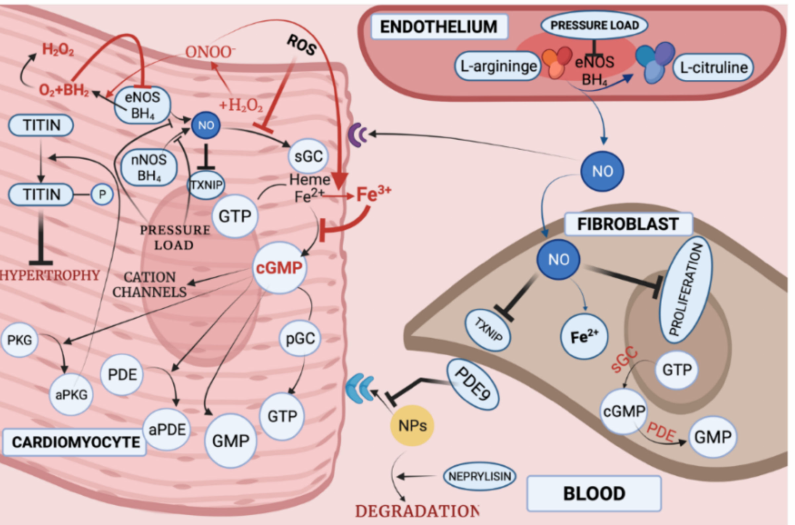
Figure 5. NO–cGMP-PKG pathway in HFpEF development (created with BioRender.com